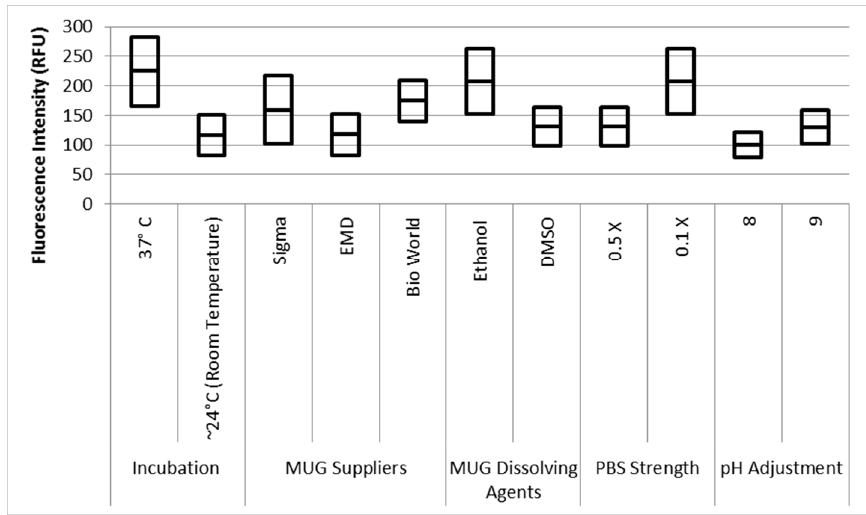
Figure 8. Effect of different assay conditions on fluorescence intensity. Note: The results have been obtained based on three replicates of each sample from three independent experiments; the units are RFU (arbitrary units) samples contained 100 CFU/mL E. coli .